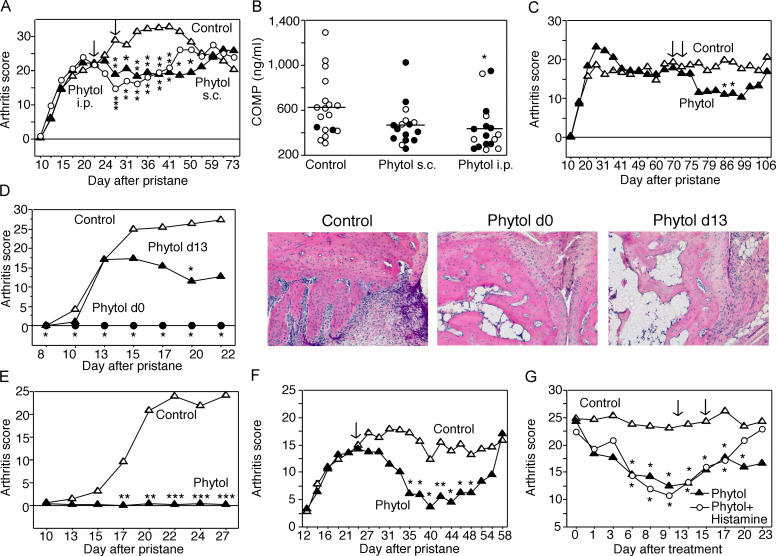
Phytol Suppresses Established Arthritis(A) Phytol injection ameliorates acute arthritis. Therapeutic effect of phytol in acute phase of PIA in DA.Ncf1
DA rats after two injections (200 μl) 5 d apart (arrows) starting at the estimated peak of disease (day 22). (Significance indications above line represent SC administration and below IP administration) (control n = 18, IP n = 17, and SC n = 16).(B) Cartilage destruction is decreased after phytol injection. Plasma were taken day 38 and analyzed for COMP levels as a measurement of cartilage destruction. Results are presented as circles, where each circle represents one individual and filled circles represent rats with a mean reduction in score after day of first treatment (day 22). Lines represent mean values.(C) Phytol decreases arthritis severity in the chronic phase of arthritis. Phytol was injected IP twice (200 μl) (arrows), starting day 70 after pristane injection in DA.Ncf1
DA rats with 3 d between treatments (control, n = 19; phytol, n = 18).(D) Phytol affects macroscopic and microscopic inflammation. Pristane-injected rats treated with phytol on either day 0 or day 13 (n = 4). On day 22 rats were sacrificed and paws taken for histology and stained with erythrosine-hematoxylin (photomicrographs to right of graph; 20× magnification).(E) The preventive effect of phytol is not dependent on genetic background. Arthritis-preventing effect of phytol when injected (200 μl SC) 5 d before induction of PIA in LEW.1F rats (n = 9).(F) Phytol has an arthritis-ameliorating effect in rats that have a functional oxidative burst. Rats heterozygous for the functional Ncf1 (Ncf1
E3) allele with an arthritis susceptibility locus on Chromosome 6 were injected IP (200 μl) with phytol at the estimated peak of disease (day 24, arrow; control, n = 13; phytol, n = 15).(G) Histamine dihydrochloride reverses the ameliorating effect of phytol, possibly by blocking oxidative burst. Injection of histamine twice (200 μl SC and IP), with 5 d between injections (arrows), starting 10 d after phytol treatment (day 26 after pristane) in DA.Ncf1
DA rats could reverse the arthritis-ameliorating effect (n = 5). Results are presented as difference in score compared to day of treatment (day 0).*p < 0.05, **p < 0.01, ***p < 0.001.